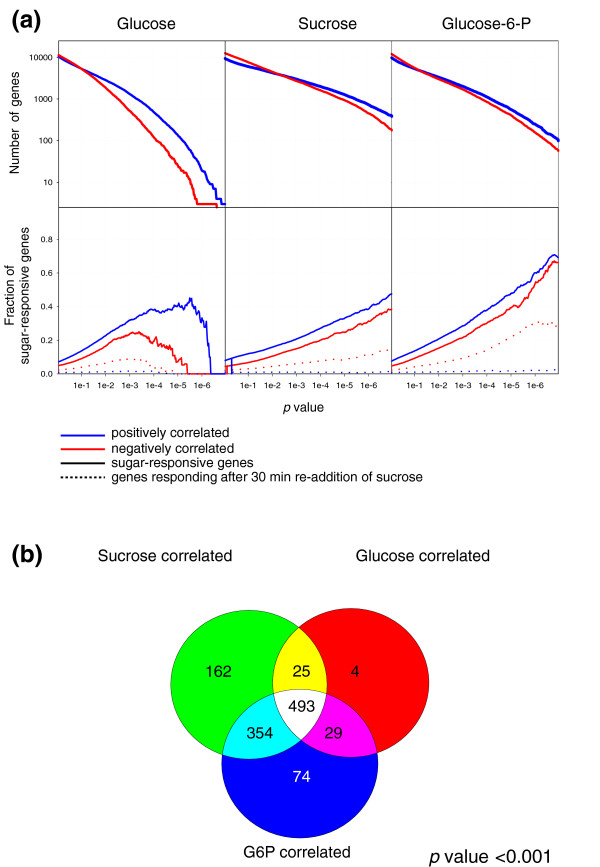
Identification of robust sugar-responsive genes whose transcripts correlate with changes in glucose, sucrose or glucose-6-phosphate during diurnal cycles in WT plants and pgm, and in an extended night treatment. (a) Correlation coefficients and corresponding p values (x axis, logarithmic scale) were calculated between the transcript levels for each of these genes and the levels of glucose, sucrose, or glucose-6P using a combined dataset, including data obtained from WT and pgm across a night and day cycle, and WT plants transferred to an extended night. The top graphs show the number of genes whose transcripts correlate with glucose (left hand), sucrose (middle) or glucose-6P (right hand) at a significance level. The bottom graphs show the proportion of the genes that correlate with a given metabolite, which are found in a set of 'sugar-responsive' genes (thick line). A set of 1,312 'sugar-responsive' genes was defined by inspection of public domain data for experiments in which sugars were added to carbon-starved seedlings for 3 h, or leaves were illuminated for 4 h in the presence and absence of CO2(see main text for details). The plot also shows a similar comparison against a set of genes that are induced or repressed within 30 minutes by addition of sucrose to starved seedlings (dotted line). Blue lines correspond to positive correlations, red lines to negative correlations. (b) Venn Diagram of sugar-regulated genes correlated to sucrose, glucose and glucose-6-phosphate with a significance level of 0.001 or better. In total, 1,141 of the 1,312 genes correlated with at least one metabolite with a p value < 10-3.